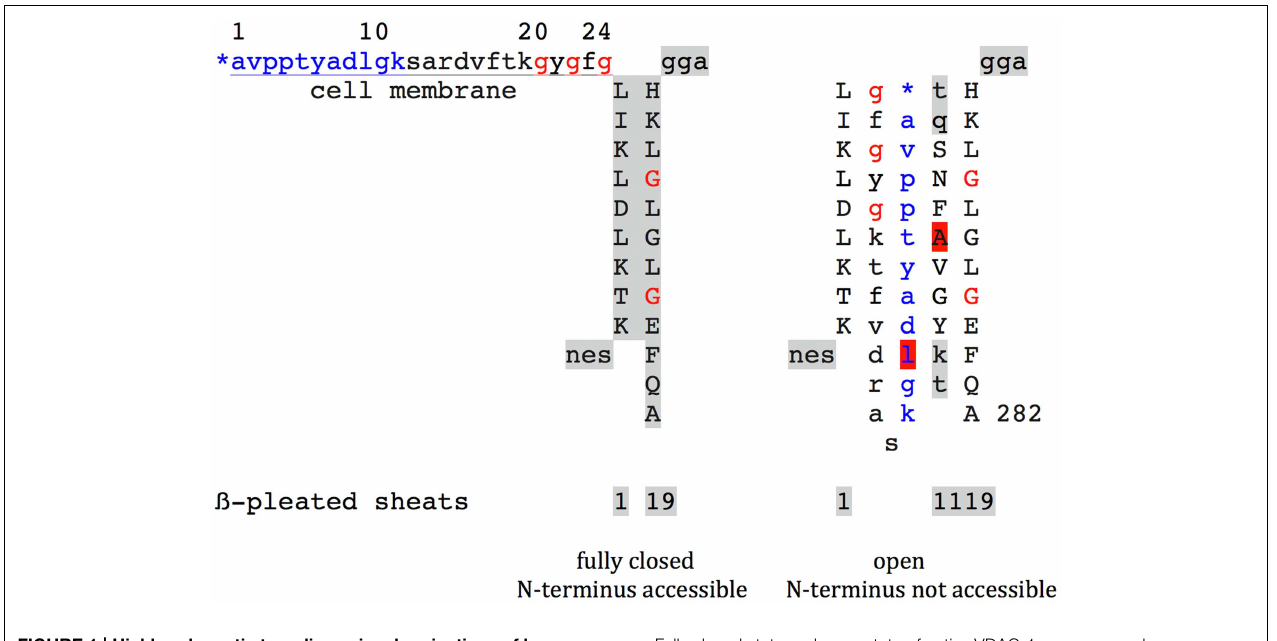
Fully closed state and open state of native VDAC-1 are compared. Noteworthy the GxxxG motif, that has been shown to work as an ATP binding site and may putatively figure as a peptide interaction/membrane perturbation